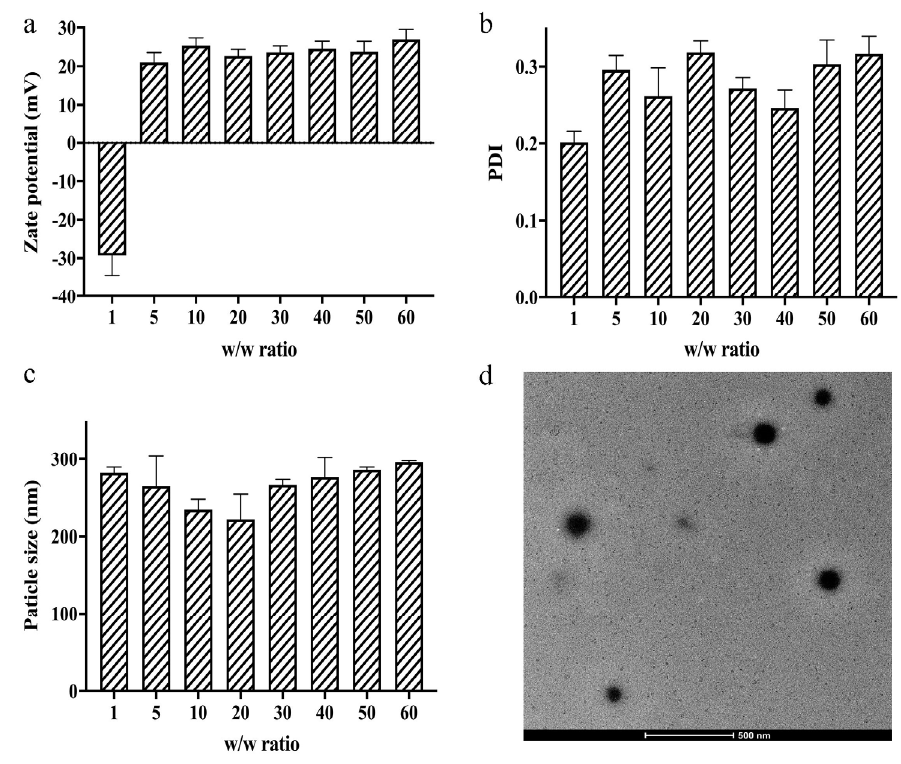
Figure 4. Characterization of TFSPEI polyplexes. ( a ) Zeta potential, ( b ) PDI, and ( c ) particle size of the polyplex. Data are shown as the mean ± S.D. (n = 3). ( d ) TEM images of the polyplex at the w/w ratio of 50.